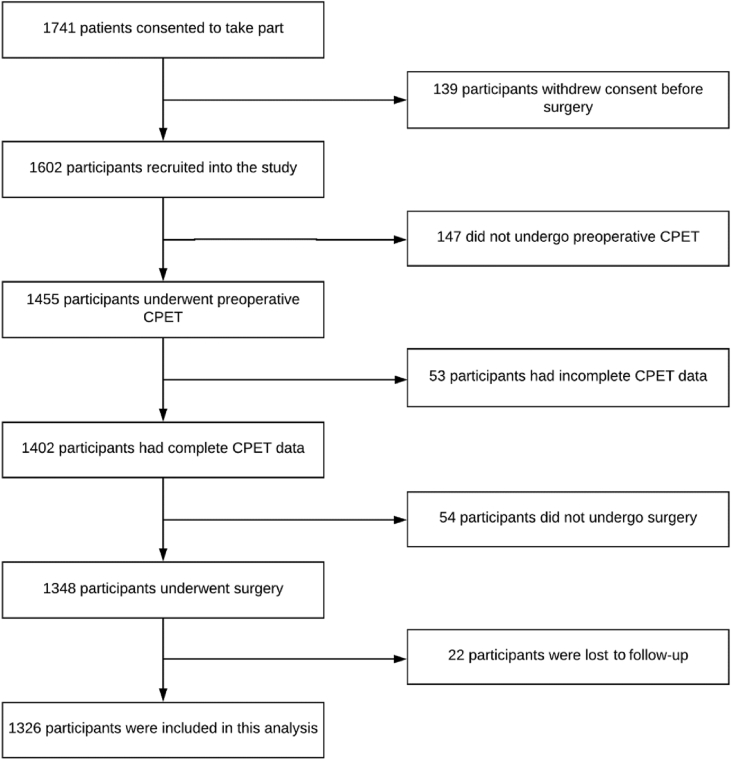
Patient flow diagram showing the number of patients included in the analysis. CPET, cardiopulmonary exercise testing.